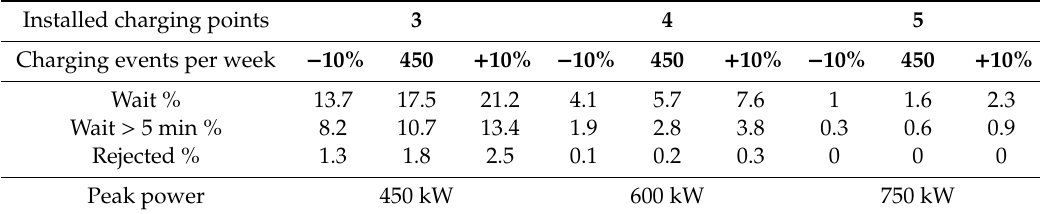
Table 2. Waiting metrics as a function of the number of installed charging points.